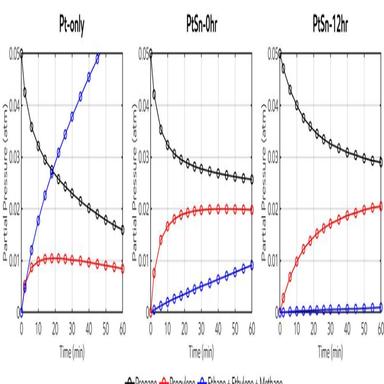
Side-by-side comparison of propane reactivity on Pt-only, PtSn-0hr, and PtSn-12hr, under the same process conditions (550 C, 0.05 atm propane, 0.1 atm H2, 5 mg catalyst).